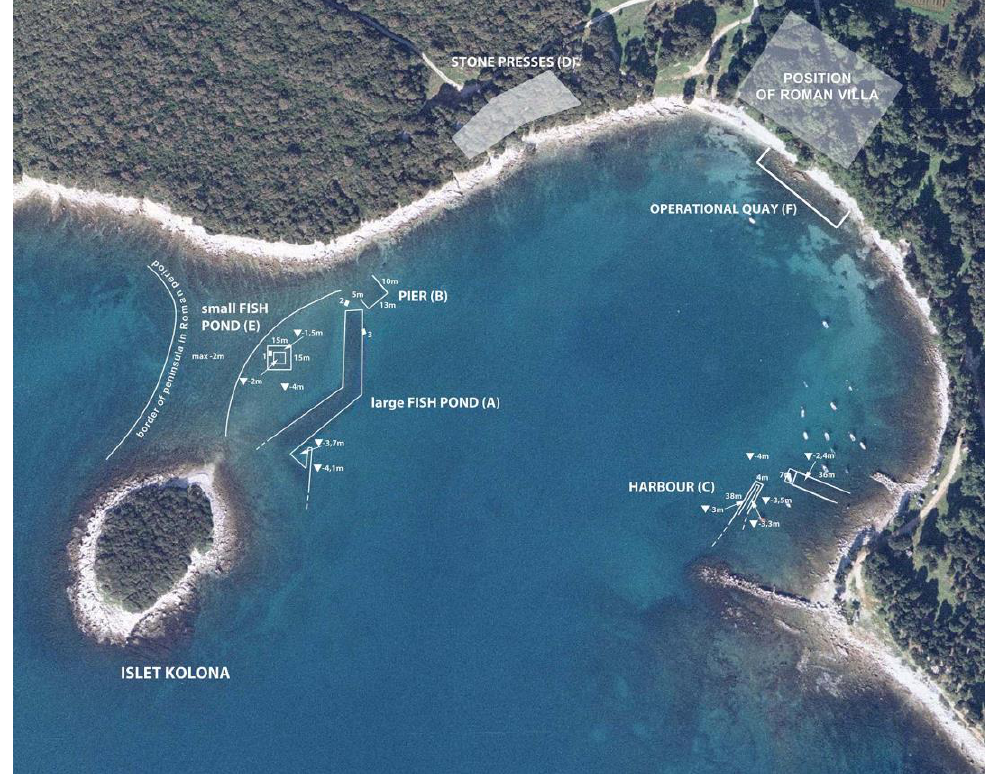
Figure 7. Interpretation drawing based on ALB derived visualizations and underwater survey © Igor